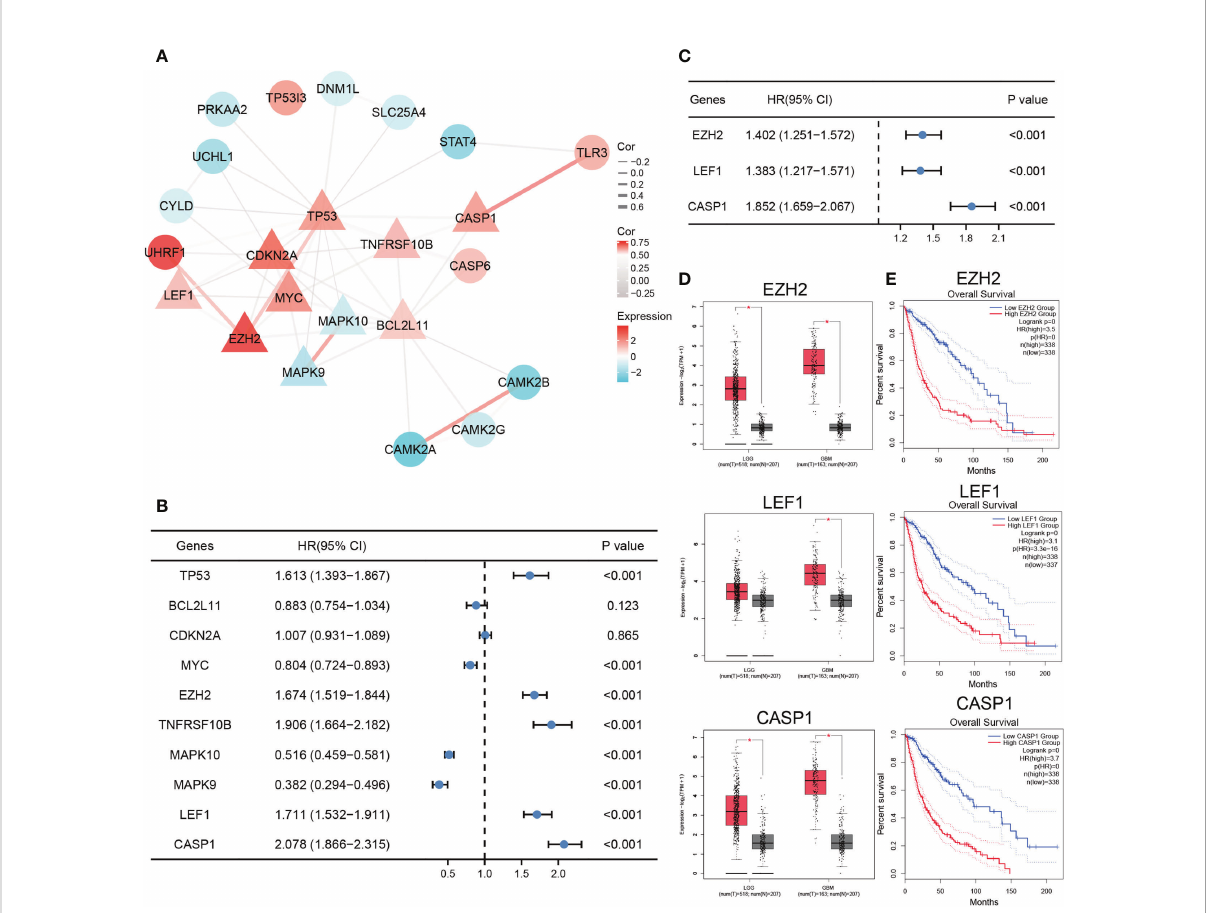
FIGURE 2 Identi fi cation of necroptosis-related prognostic DEGs. (A) The PPI network of the necroptosis-related DEGs. Triangles represent hub genes identi fi ed by the degree algorithm. The thickness of the line represents the strength of the correlation. (B) Univariate Cox regression analysis of top ten hub genes. (C) EZH2 , LEF1 , and CASP1 were identi fi ed as signi fi cant prognostic genes for glioma in multivariate Cox regression analysis. (D, E) The expression and survival analysis of EZH2 , LEF1 , and CASP1 in glioma based on GEPIA (* p <